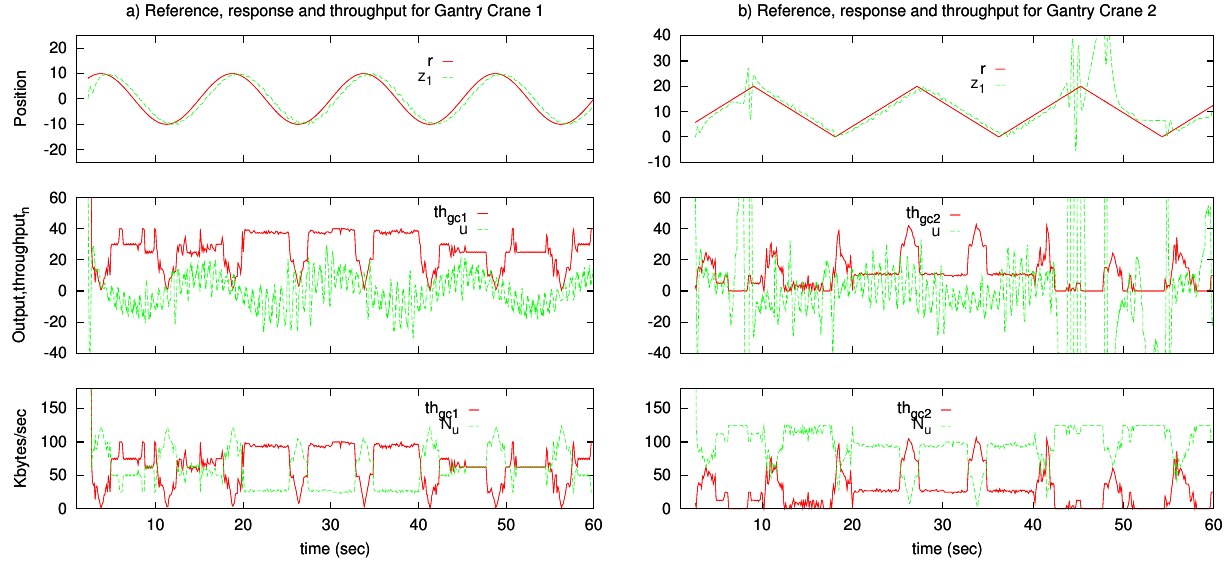
Figure 11. Simulation results for constant